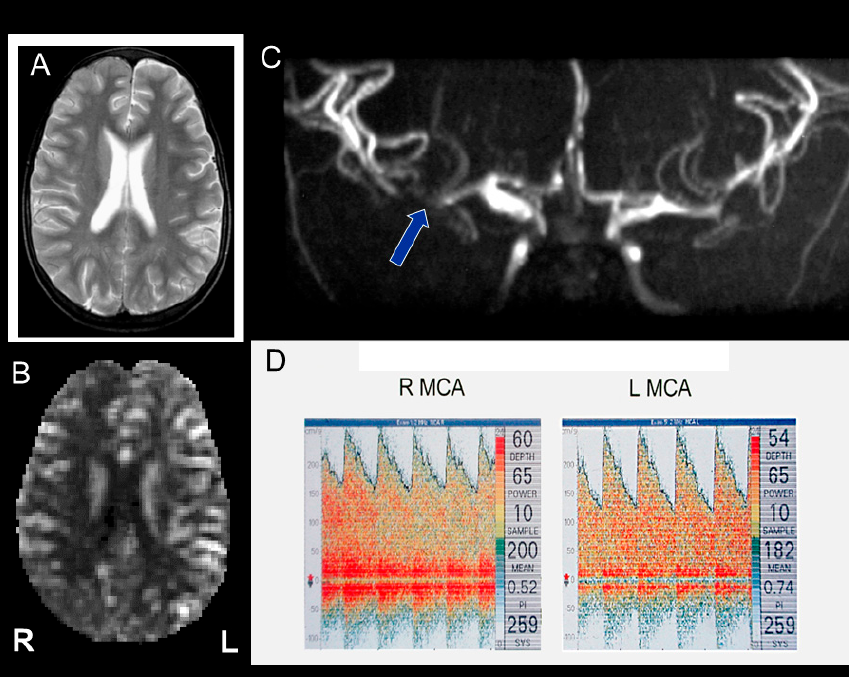
Figure 2. Magnetic resonance imaging (MRI) and transcranial Doppler) (TCD) in an 11 year old child with headache after a chest crisis. ( A ) T2-weighted MRI was normal but ( B ) there was reduced cerebral blood flow throughout the right hemisphere and posteriorly on the left. ( C ) Magnetic resonance angiography (MRA) showed signal dropout in the middle cerebral arteries, worse on the right, which manifest as ( D ) Abnormal and Conditional time averaged mean of the maximum velocity on the right and left respectively. He was transfused for a year and both MRI and TCD returned to normal.